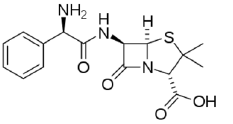
Figure 1. Chemical structures of the tested